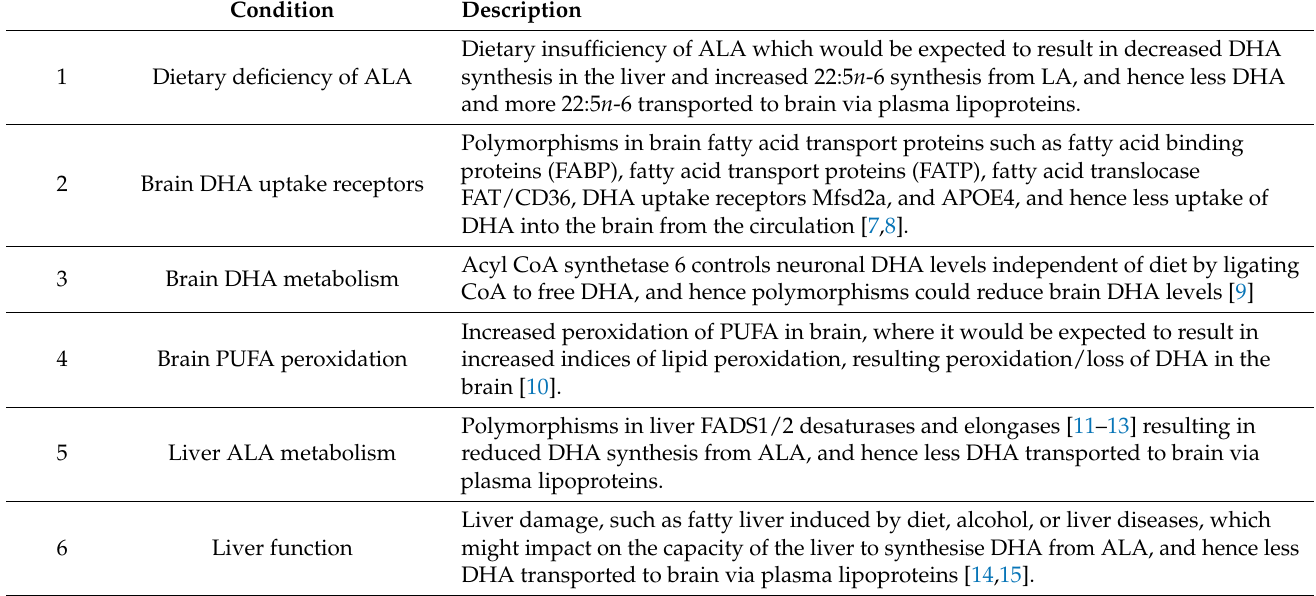
Table 1. Conditions associated with reduced neural DHA